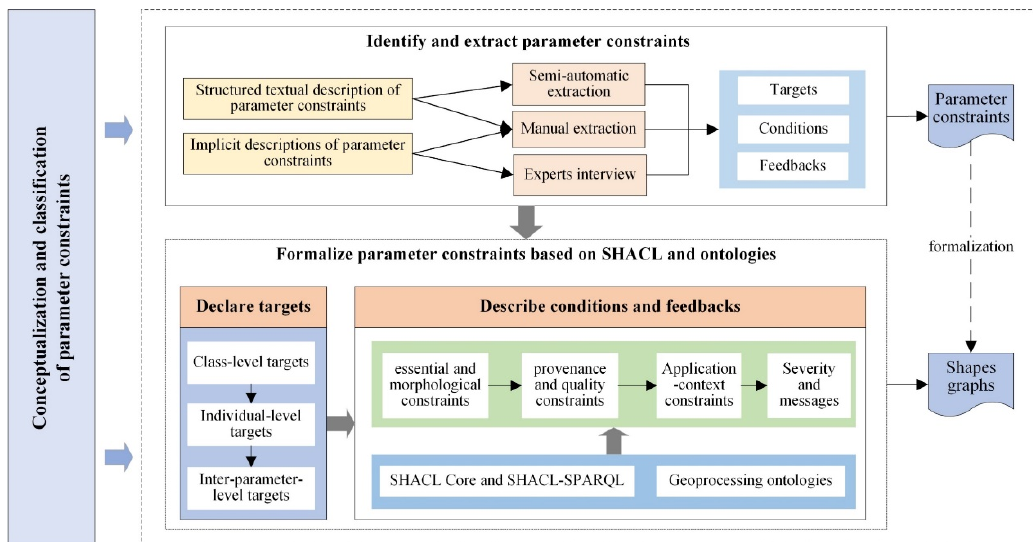
Figure 4. Framework of the proposed method.